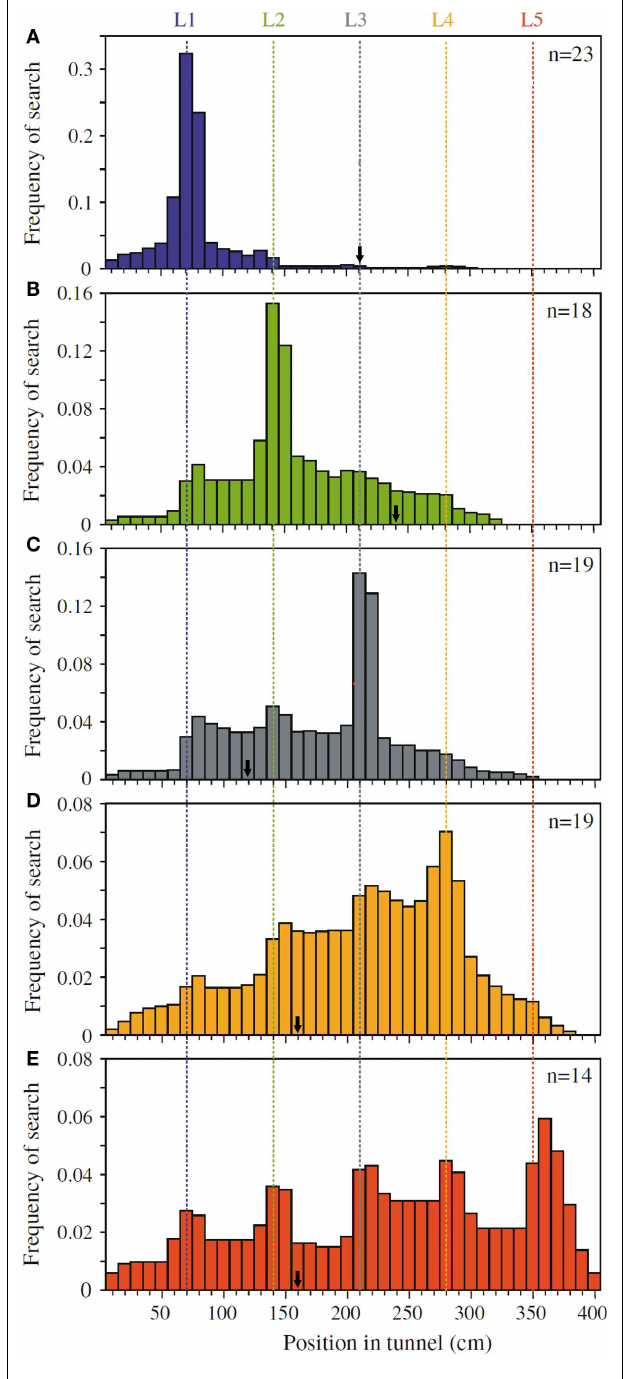
FIGURE 2 | Pinpointing the rewarded landmark in a series of landmarks. Shown are the search distributions of bees that are tested after being trained to receive a reward at (A) landmark 1, (B) landmark 2, (C) landmark 3, (D) landmark 4, and (E) landmark 5. Bees trained to landmark 1 show a strong preference to search around landmark 1 (A) . Bees trained to landmark two similarly prefer to search near landmark 2 (B) , and so on (C–E) .The arrows mark the position of the rewarded landmark in the training, just prior to each test. Adapted with permission from Dacke and Srinivasan